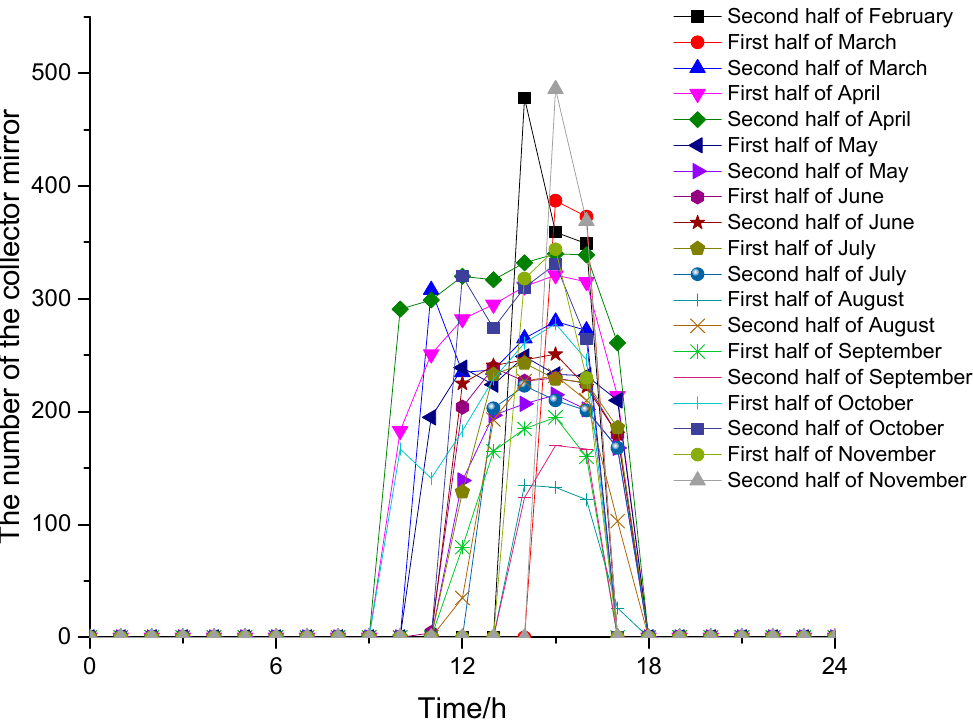
Figure 16. The average number of the collector mirror on the side of the HRSG for every half month.